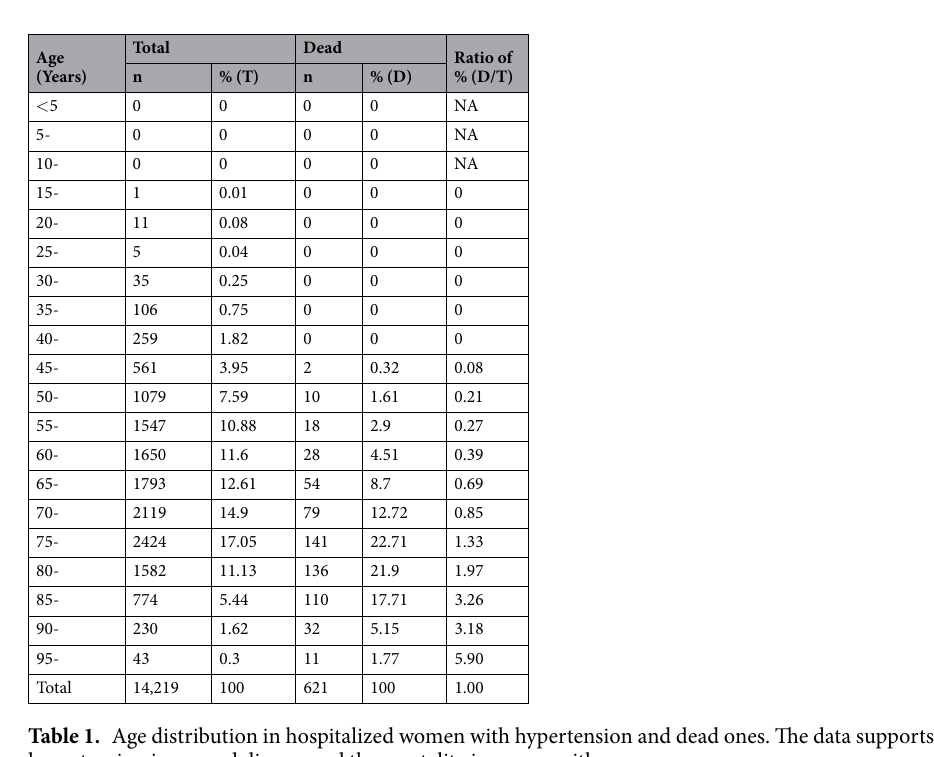
Figure 1. Data profile. In the end, 14219 women with hypertension were analyzed as base line in current study; among them, 4.4% was mortality.